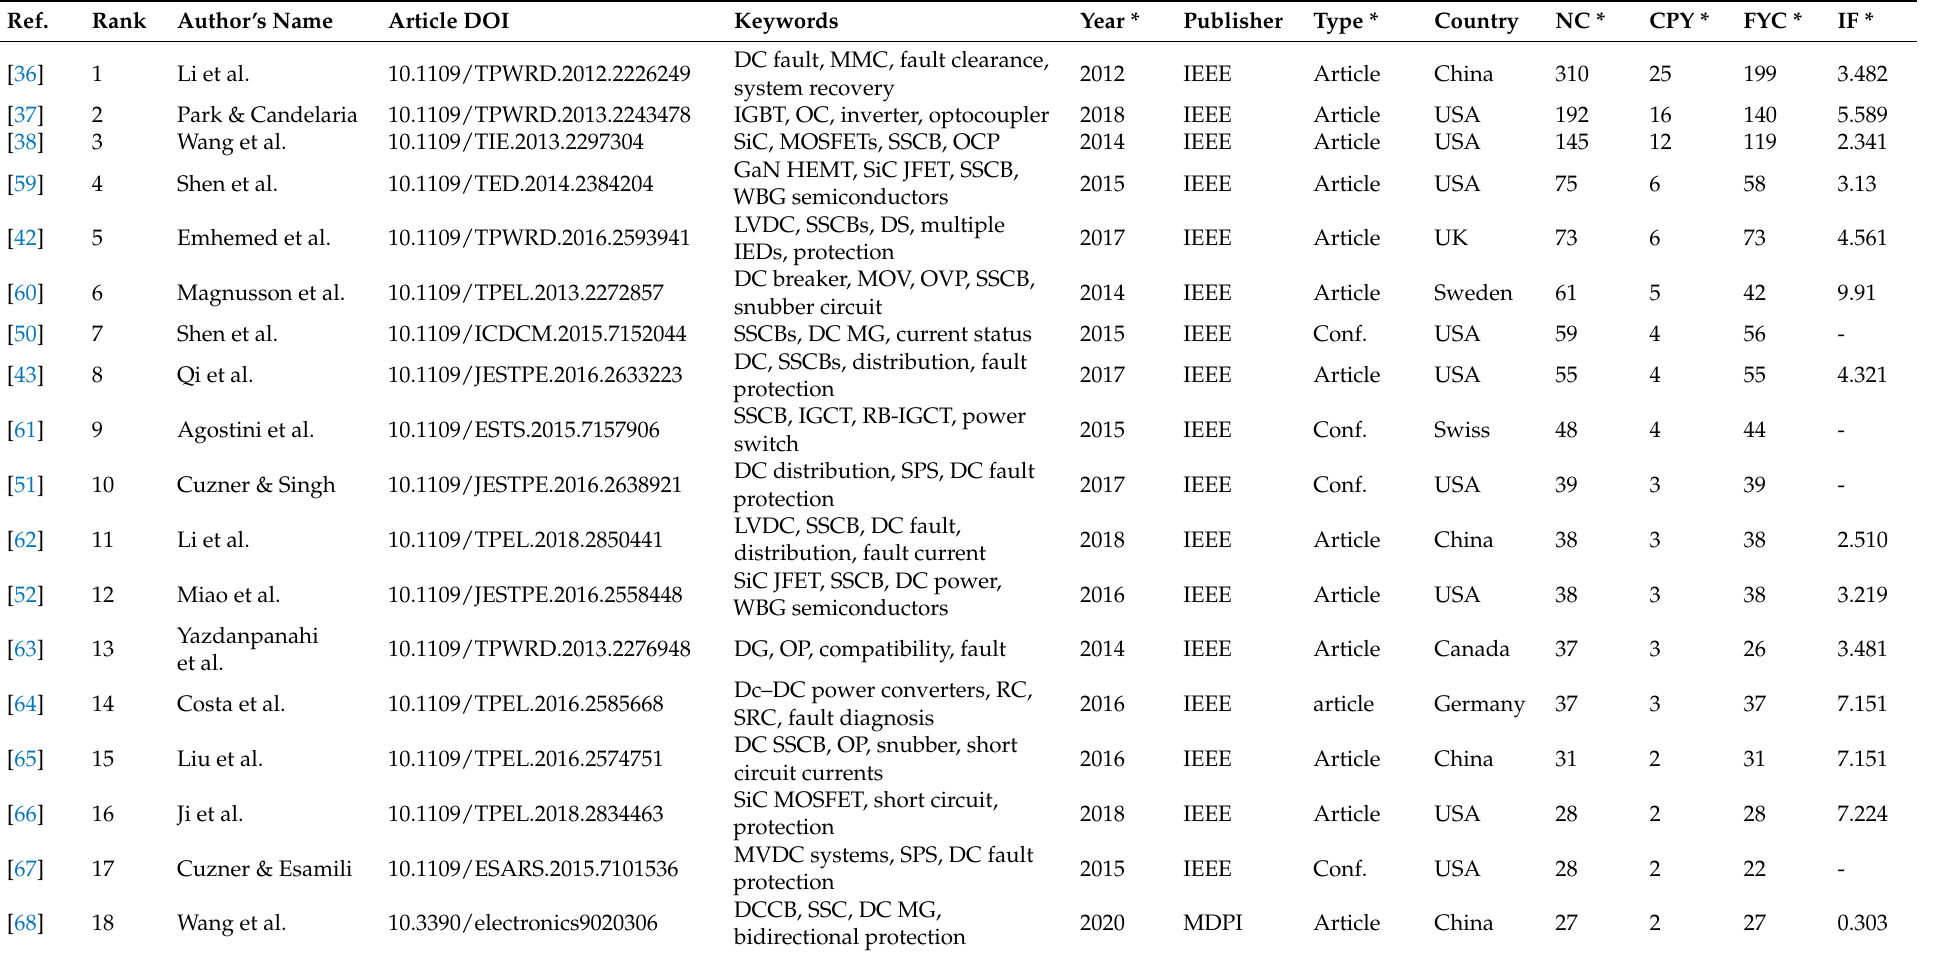
Table 1. The 120 papers list for Solid State Switching keywords and publication